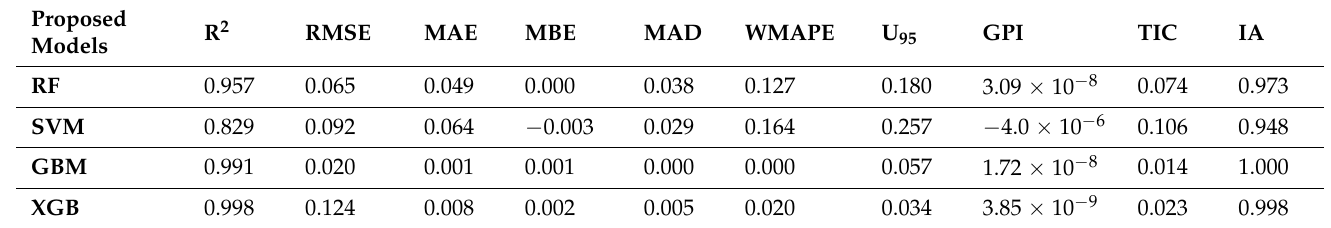
Table 8. Overall rank analysis of different performance parameters for different machine learning Table 7. The value of different performance parameters for different machine learning techniques in techniques. predicting the group capacity of a testing